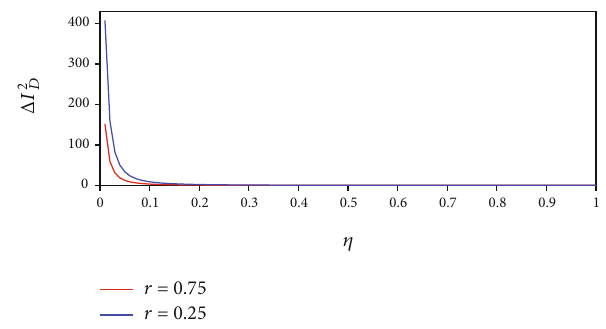
Figure 6: Plots of intensity di ff erence fl uctuation (Equation (32)) versus η for A = 100 and κ = 0 : 8 and for di ff erent values of squeeze